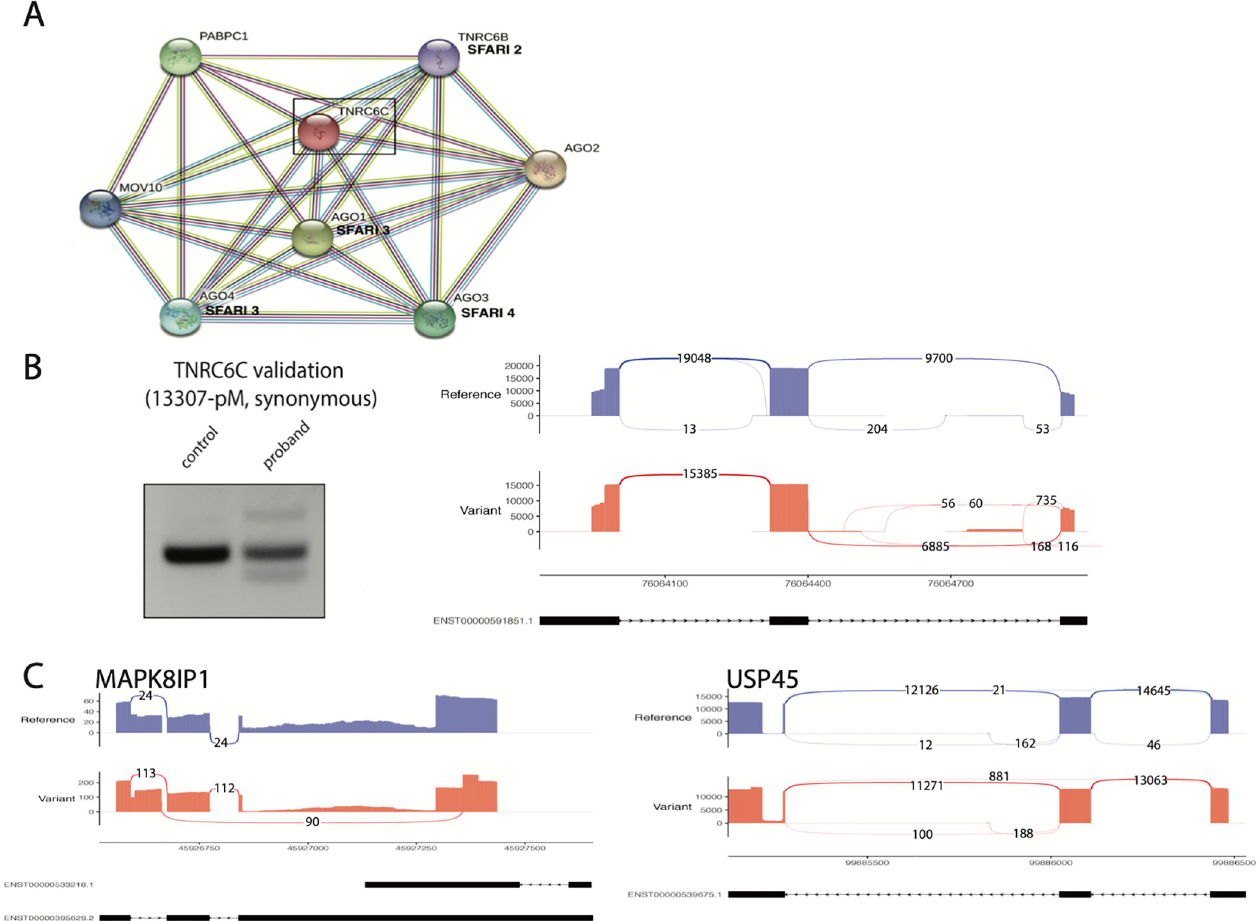
Fig 3. Protein interaction network of TNRC6C reveals connections to ‘candidate ASD genes’. A . STRING interaction network of TNRC6C highlights interactions with genes associated with ASD risk. B. Tissue sample validation of TNRC6C (left) shows upregulation of alternative splicing events in the proband sample, particularly as skipping event (88 bp band). Amplicon sequencing sashimi plot (right) confirms complex splicing phenotype in proband (variant) relative to control sample (reference). C . Amplicon sequencing Sashimi plots (left) display complex splicing phenotypes, particularly exon skipping, in the variant sample relative to the control for MAPK8IP1 and a less substantial splicing phenotype of the USP45 variant relative.